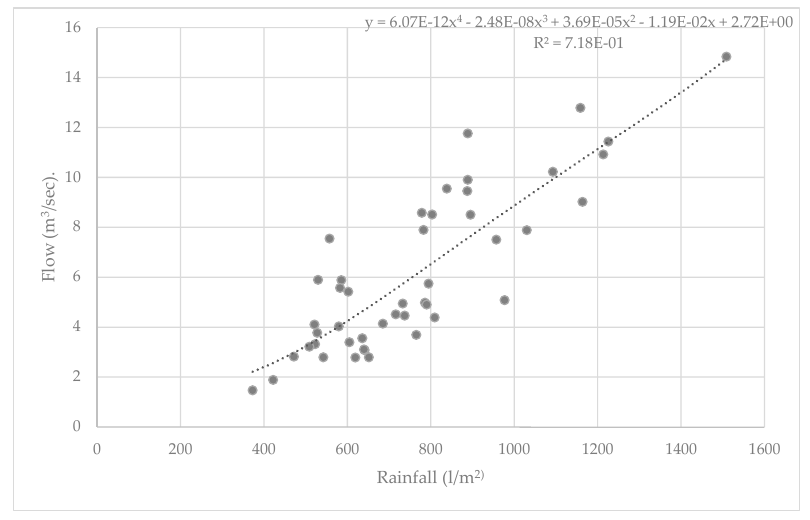
Figure 14. Flow and rainfall data (1967–2012), Tranco de Beas center. Source: Own elaboration based on data from ENDESA.